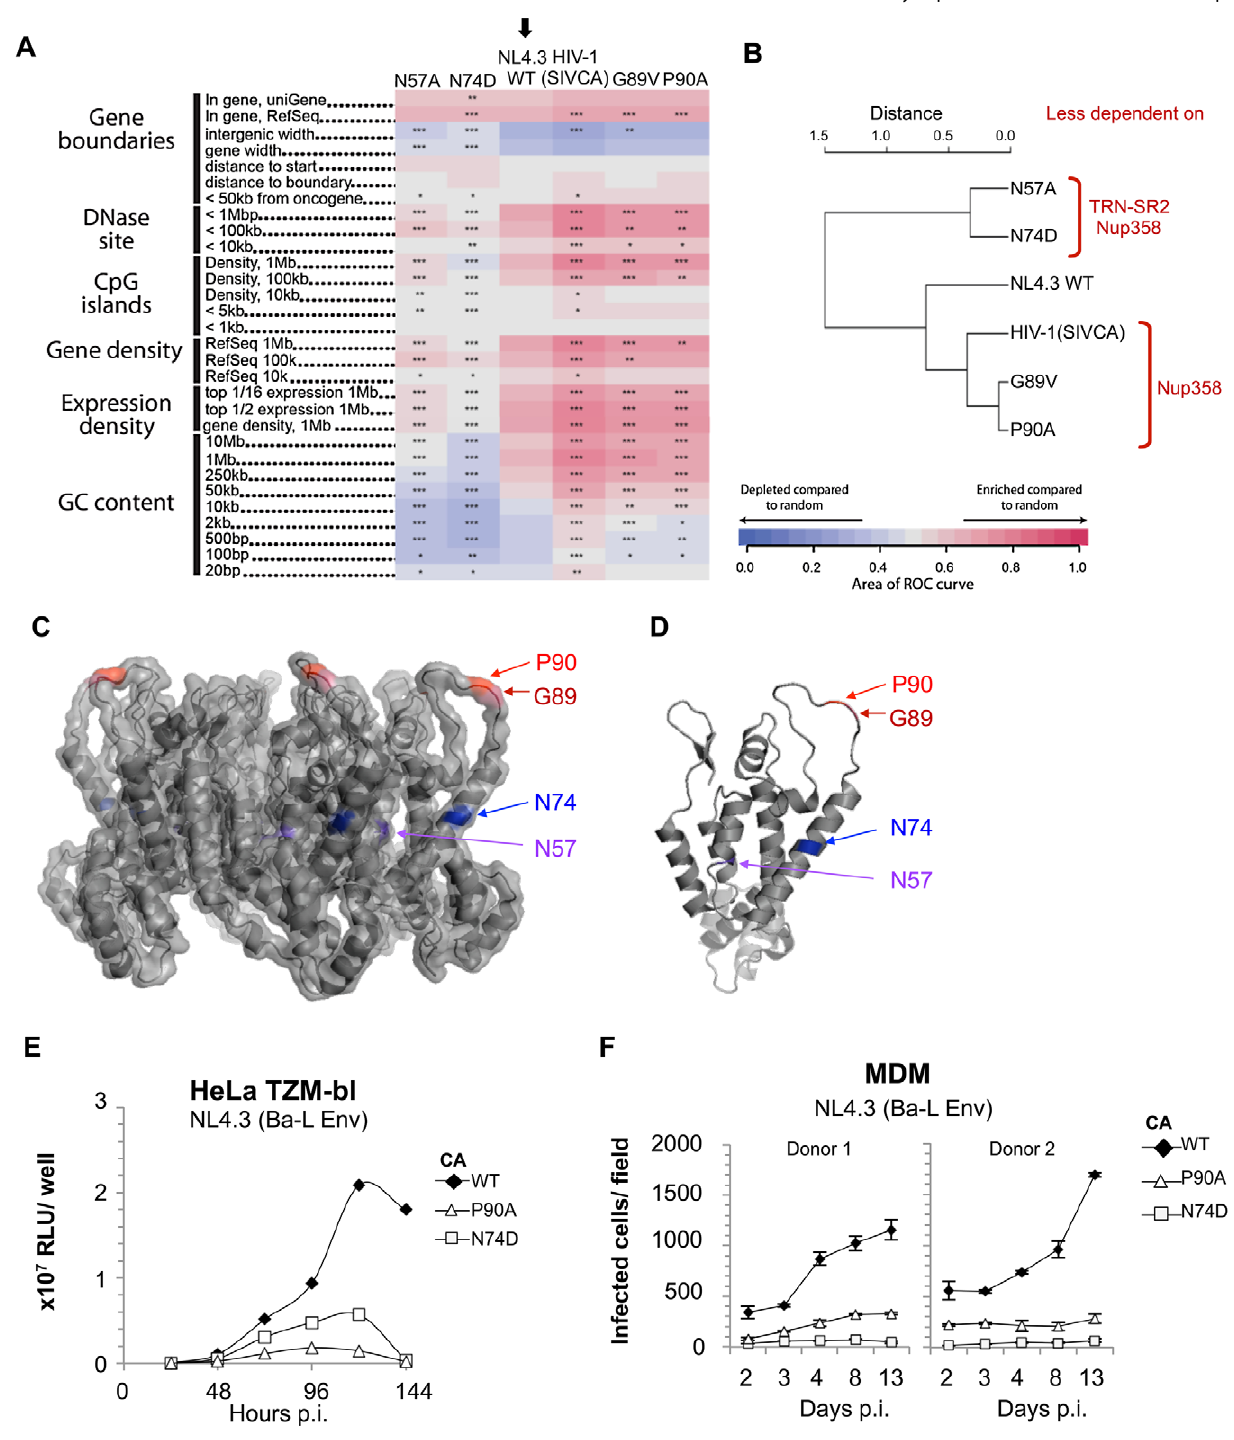
Figure 4. Residue changes in HIV-1 CA mutants alter integration site targeting. A , Effects of CA mutants on integration frequency near multiple chromosomal features. The rows show genomic features, and the columns indicate integration site data sets. The color code indicates ROC areas [34]. The arrow denotes the wild type control set used for pairwise statistical comparisons to the other data sets. P values summarizing the significance of departures from the control are represented by asterisks (*P , 0.05; **P , 0.01; ***P , 0.001). Several different intervals are compared. "Expression density" summarizes the density of genes in the indicated length intervals that are expressed in the upper half ("top 1/2") or upper sixteenth ("top 1/6") of all genes on Affymetrix HU95A chip data for HeLa cells (accessions GSM23372, GSM23373, GSM23377, and GSM23378). For a more detailed guide see [16]. B , ROC area values were used to generate pairwise Euclidean distances, which were then analyzed by hierarchical clustering generating the presented dendogram. The locations of changed residues in mutant viruses studied on C , the CA hexamer (PDB:3GV2) and D , the CA monomer (PDB:3GV2). E , Time course of replication competent NL4.3 (Ba-L Env) bearing wild type, P90A or N74D CA in HeLa TZM-bl cells. Luciferase expression was measured by counting RLU at indicated times after virus inoculation. The data are representative of two independent experiments. F , Replication assay of NL4.3 (Ba-L Env) bearing wild type or CA mutants P90A or N74D in human MDM. Cells were stained for Gag p24 at specific time points after infection and infected colonies counted. Standard errors of the mean of three fields are shown. doi:10.1371/journal.ppat.1002439.g004 PLoS Pathogens |